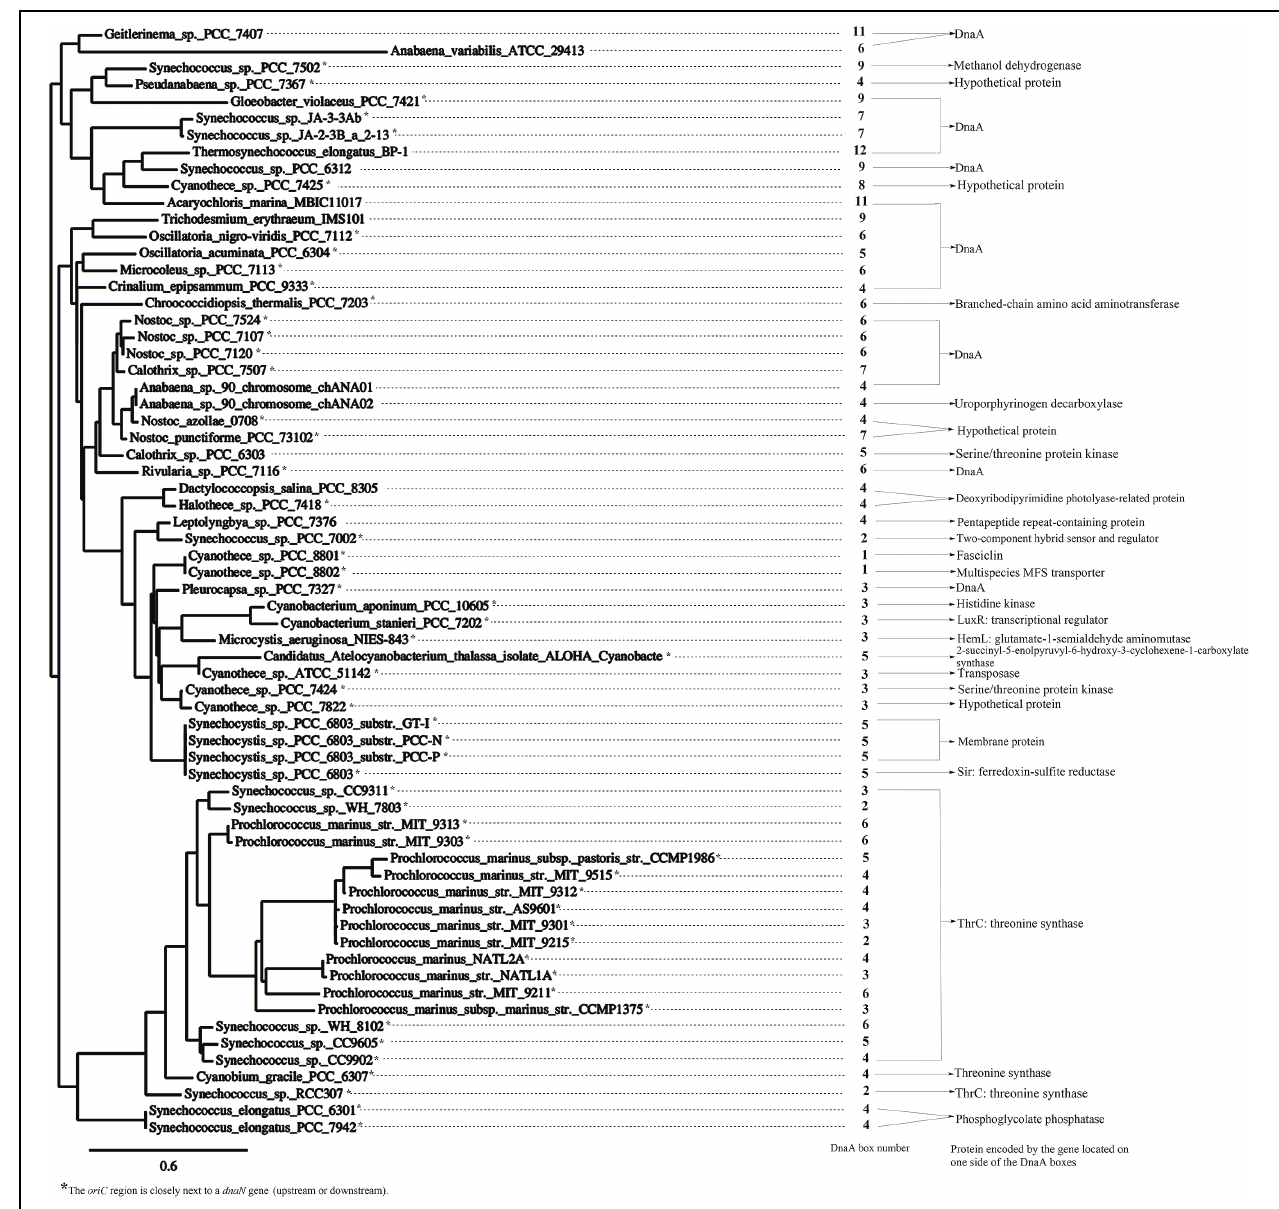
FIGURE 2 | The supplemental phylogenetic tree of cyanobacteria and information about the predicted oriC regions. The figure was drawn in a similar style to that of Zhou et al. (2011), in which 38 species of cyanobacteria were shown. The phylogenetic tree was constructed with dnaN genes from 68 species of cyanobacteria. The sequences of DnaA boxes in most of the cyanobacteria are TTTTCCACA. Fifty-five species (indicated by an asterisk) have dnaN on one side, and the genes located on the other side of oriC are indicated on the right. Note that the oriC regions of the Synechocystis sp. PCC 6803 substr. GT-I, substr. PCC-N, and substr. PCC-P overlap the membrane protein coding